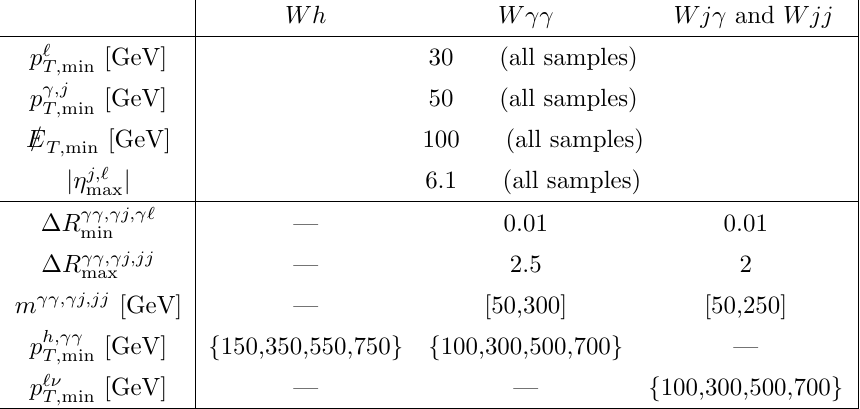
Table 7 . Parton level generation cuts for the signal and background processes. Each element in the list of values for p h;(cid:13)(cid:13) and p ‘(cid:23) corresponds to the cut used in 4 di(cid:11)erent generation runs. Each T T run was used in the analysis of the corresponding p h bin. The last generation bin is used for both T the fourth and (cid:12)fth (over(cid:13)ow) bin.